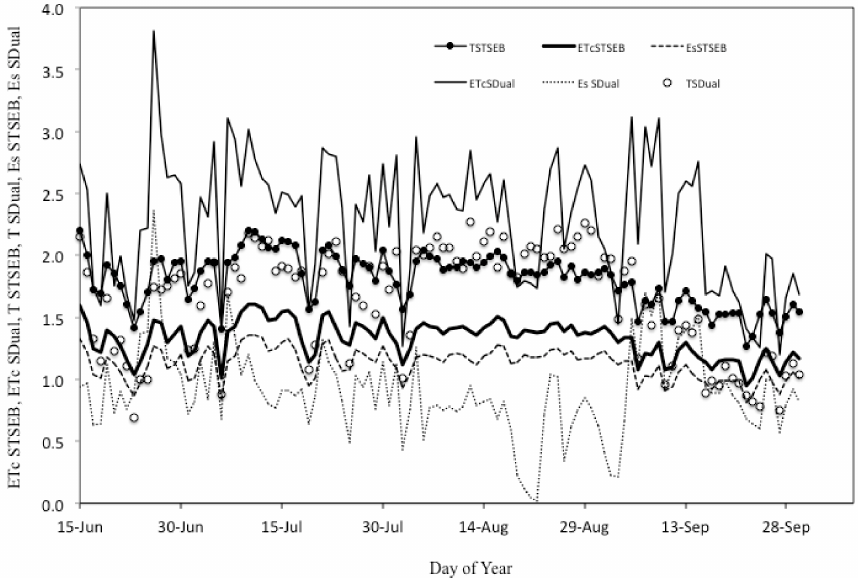
Figure 6. Comparing actual evapotranspiration ( ET cSDual ), transpiration ( T cSDual ), and soil evaporation ( E sSDual ) modeled with SIMDualKc with STSEB modeled evapotranspiration ( ET cSTSEB ), transpiration ( T STSEB ), and soil evaporation ( E sSTSEB ) for 2014 (DOY 130 to 276). Plotted values are in mm d − 1 . The deviation of E sSTSEB from the values obtained with the SIMDualKc model is